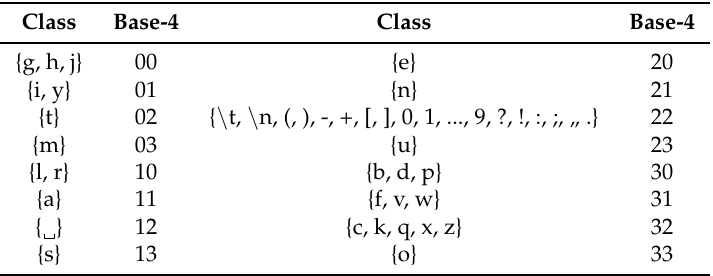
Table 1. Each letter from class column is replaced by the pair of